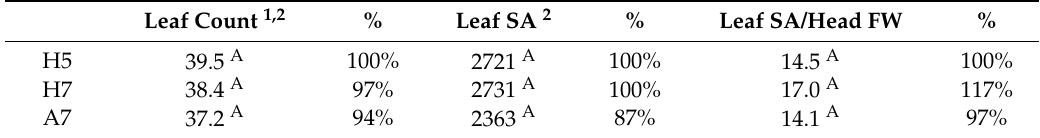
Table 9. Leaf count, leaf surface area (SA, cm 2 ), and leaf surface area/head fresh weight (cm 2 /g) response by treatment. Differing letters within response variables (columns) denote significance at alpha =